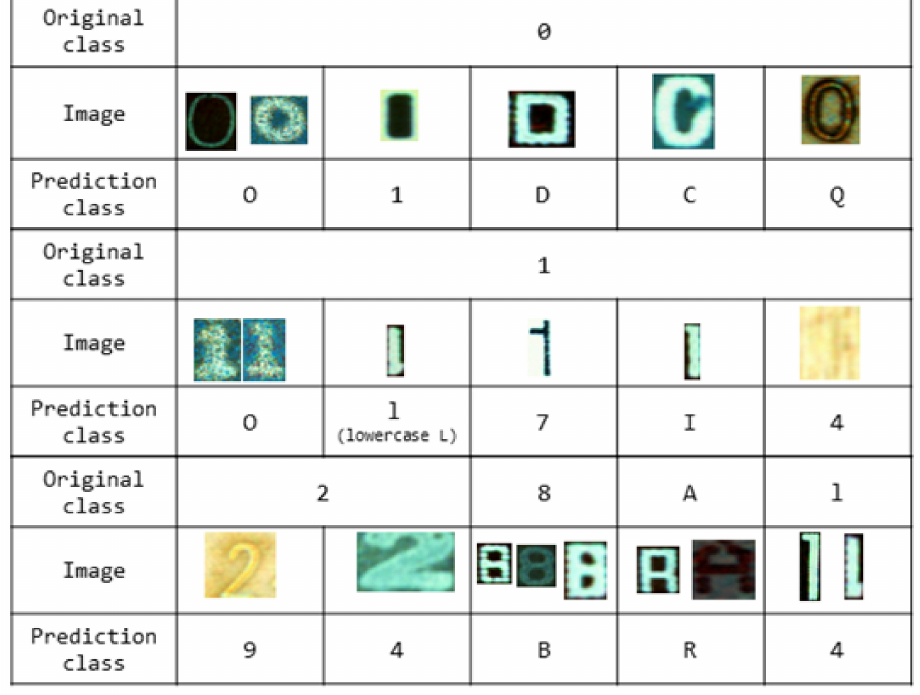
Figure 16. EfficientNet B7 error cases with 8000 images per